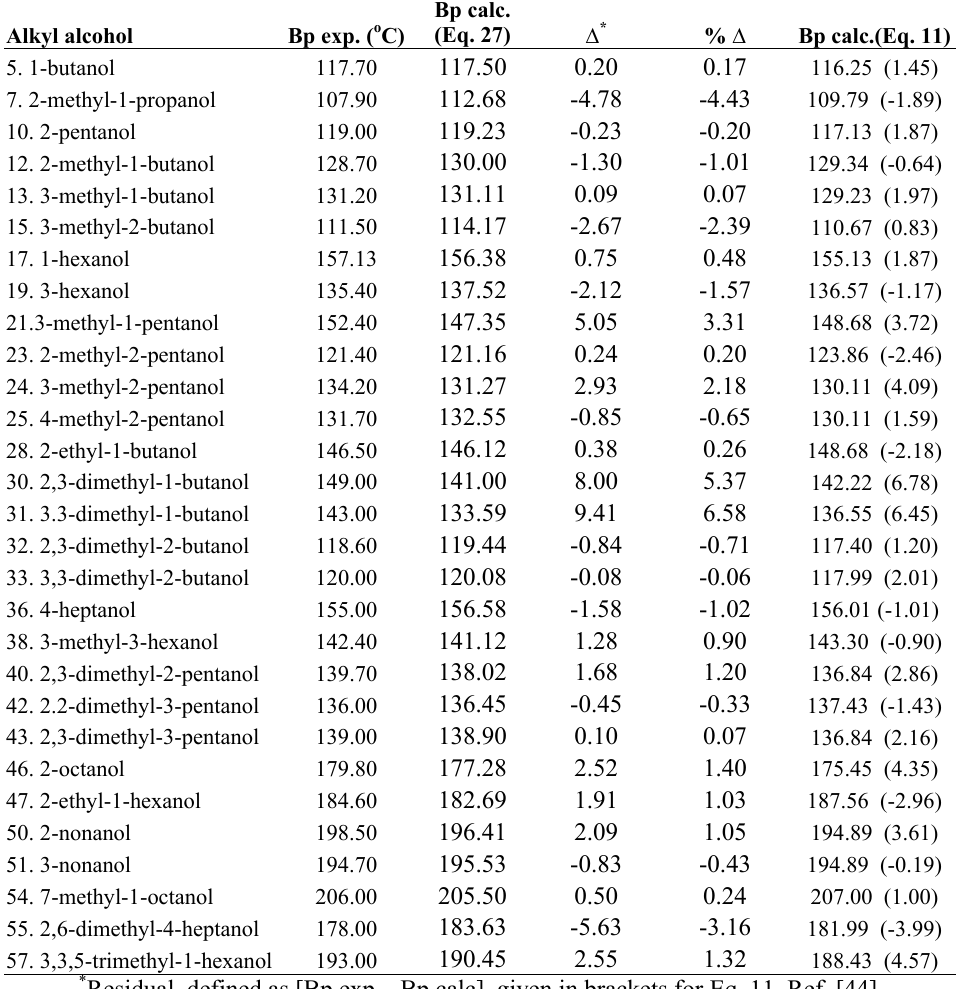
Table 10. Experimental and Calculated Bp of Alkyl alcohols in Test